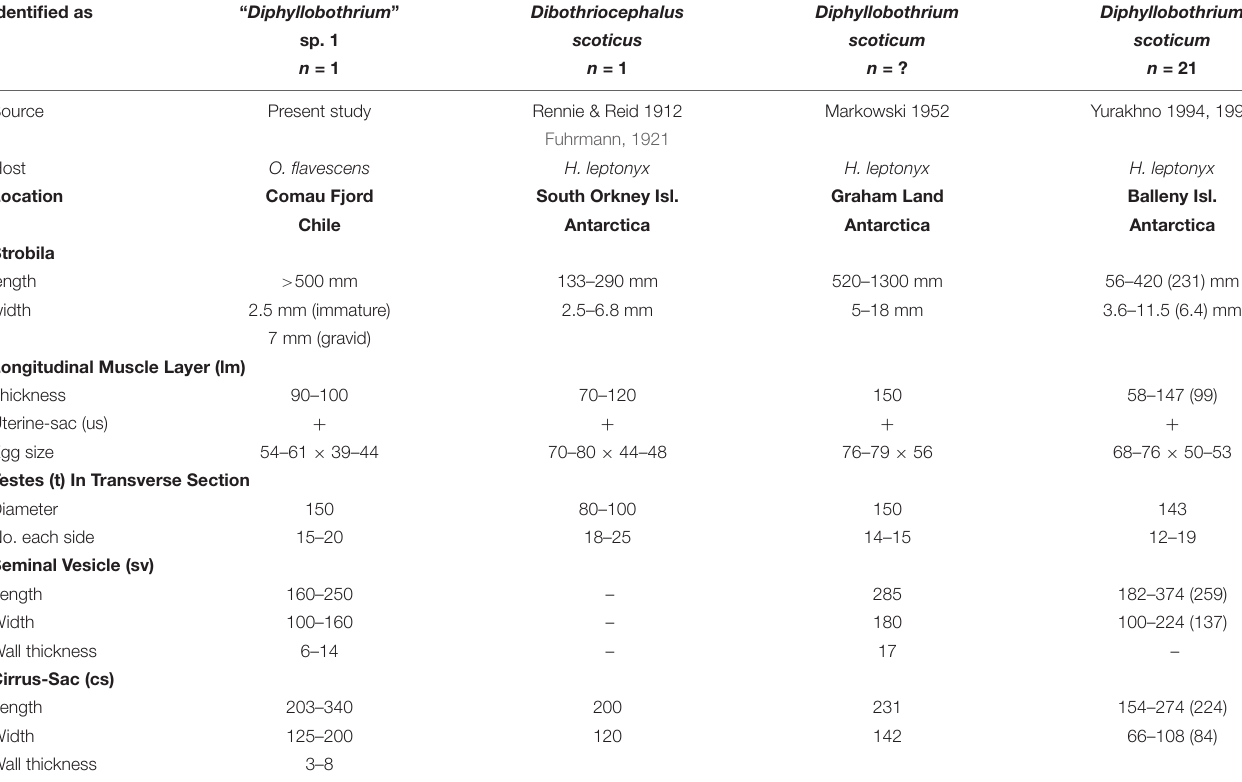
TABLE 2 | Morphometric data of “ Diphyllobothrium ” sp. 1 from Otaria flavescens compared to “ Dip ”. scoticum from H. leptonyx based on literature [ µ m;